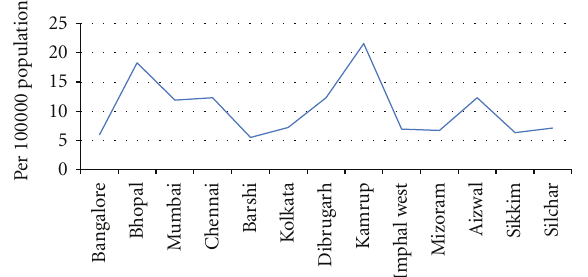
Figure 3: Age standardized incidence rates per 100,000 population (in males only). 2004-2005 reported in Manoharan et al. [3].